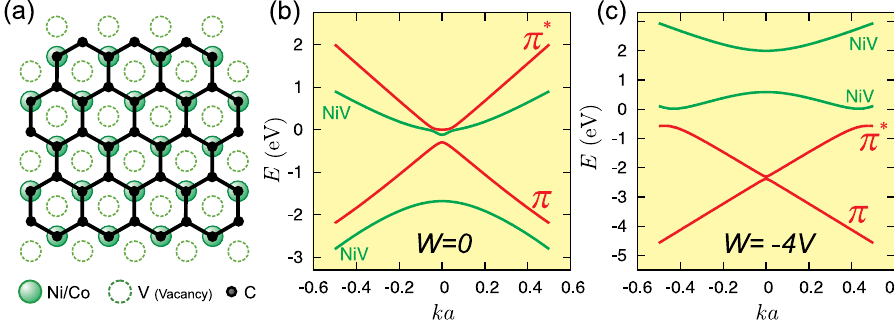
¼ (cid:3) 0 : 3 eV , E ¼ (cid:3) 1 : 5 eV , s C